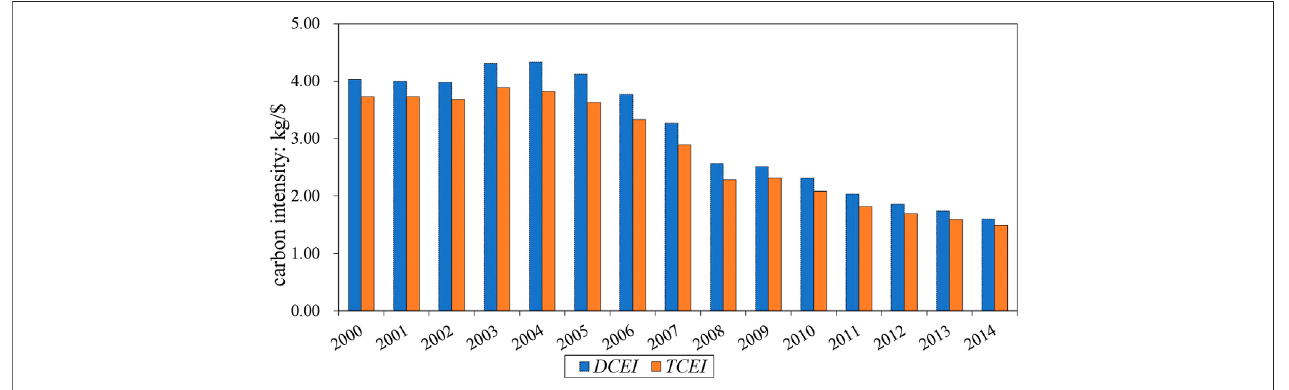
FIGURE 3 | DCEI and TCEI of China ’ s construction industry during 2000 –